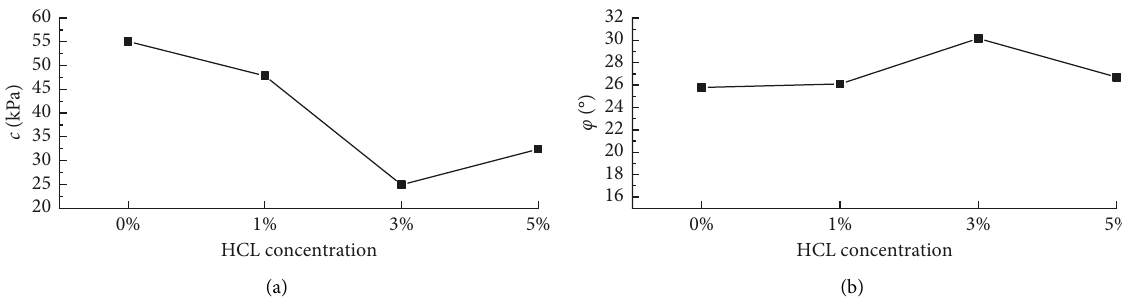
Figure 3: c and φ of acid-contaminated clay with different acid concentrations. (a) Cohesion variation. (b) Internal friction angle